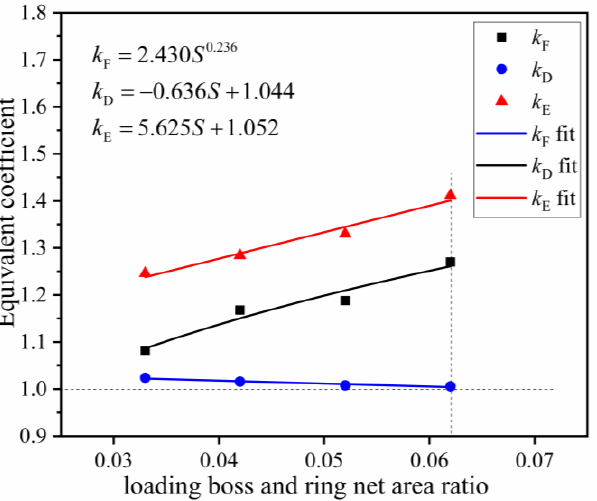
Figure 21. Equivalent coefficients at different loading head areas to ring net area ratios.